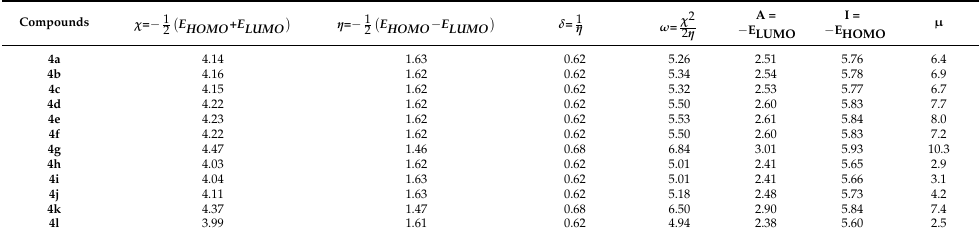
Table 6. Chemical reactivity descriptors and dipole moment ( µ , Debye) of investigated compounds 4a-l